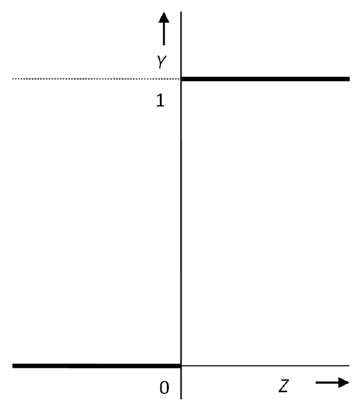
Figure 3. Non-linear Heaviside step function.